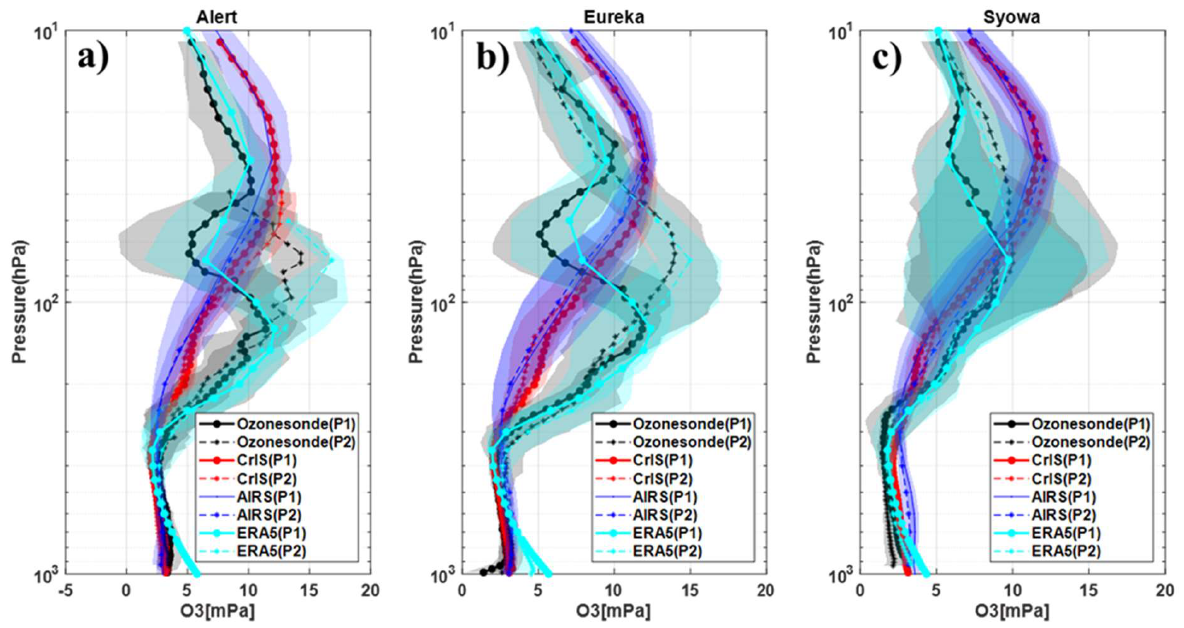
Figure 9. The comparison of ozone profiles from ozonesonde, CrIS, AIRS, and ERA5 during the P1 (ozone hole) and P2 (non-ozone hole) phases: ( a ) Alert; ( b ) Eureka; ( c ) Syowa.